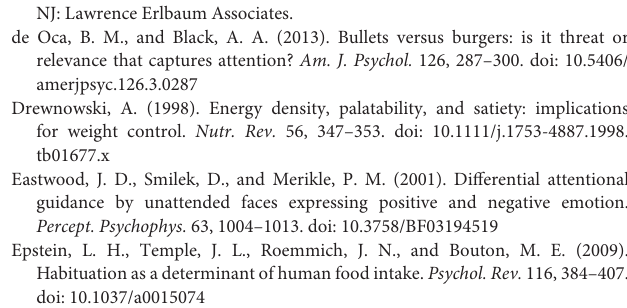
FIGURE S1 | Schematic illustration of all stimuli. Actual stimuli were full-color